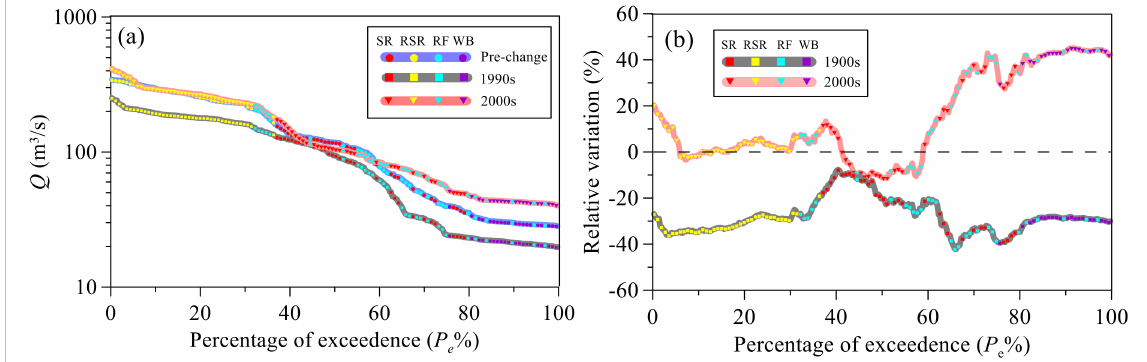
Figure 4. ( a ) Comparison of flow duration curves of the three periods ( b ) Relative changes of di ff erent percentile runo ff in di ff erent periods.